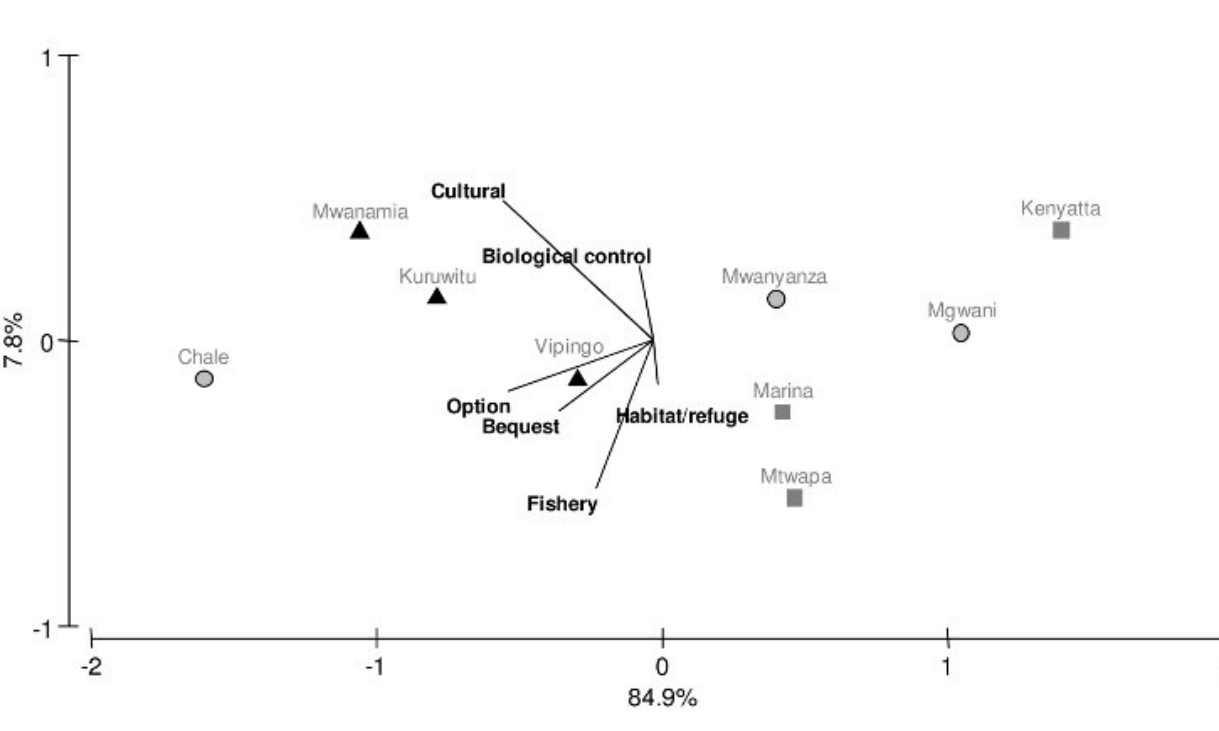
Fig. 4. Pearson’s correlation analysis (linear, indirect gradient analysis) of the sites showing only the community-level goods and services overlain as eigenvectors. PC1 represents 84.1% and PC2 represents 7.8% of the variation. Community (black triangle), Government (dark-gray square), Co- (light-gray circle), economic value (black